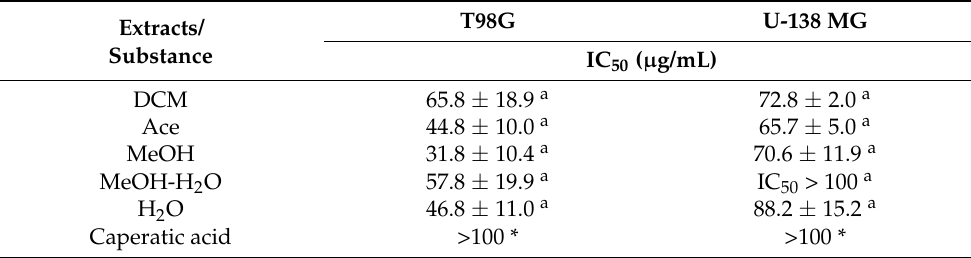
Table 8. The IC 50 of the analysed lichen-derived extracts established after 48 h treatment of T98G and U-138 MG cell